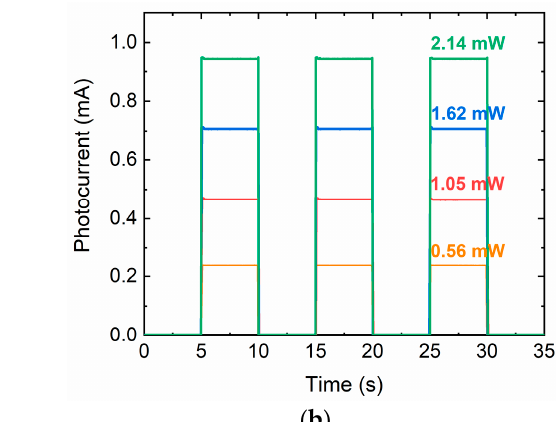
Table 3. Performance comparison for the top illuminated Ge p-i-n photodetectors.